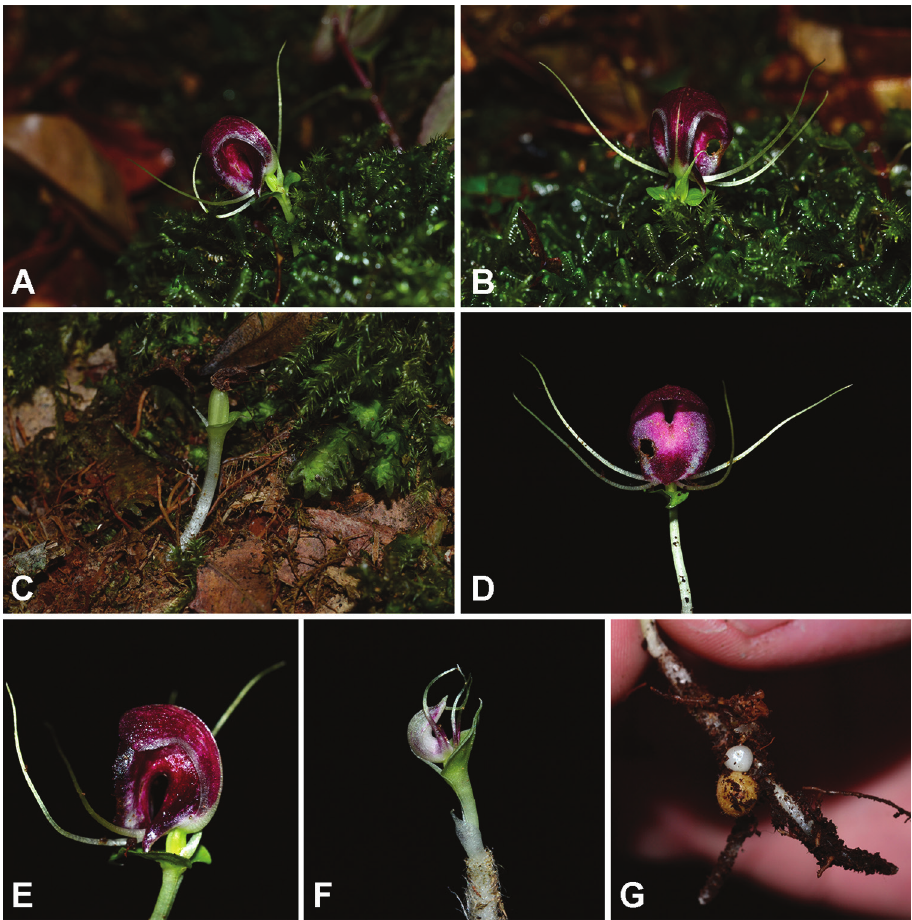
Figure 1. Corybas papillatus Inuthai, Chantanaorr. & Suddee A, B plants in natural habitat, on humus associated with Bazzania sp. and Acroporium sp. C plant with immature fruit D, E flowers D front view E lateral view F immature flower G underground parts with tubers. Photographs by W.